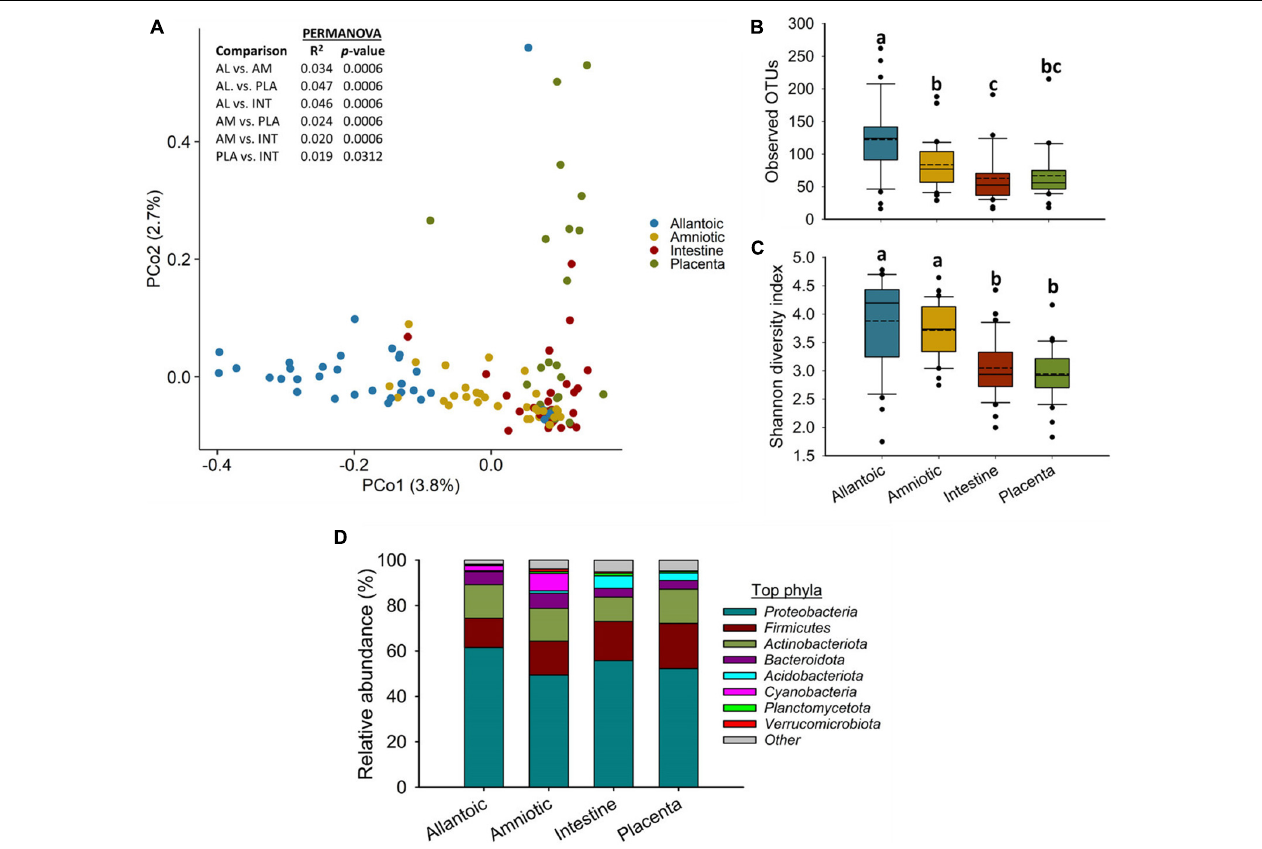
FIGURE 1 | (A) Principal coordinate analysis (PCoA) plot of the Bray-Curtis dissimilarities, (B) the number of operational taxonomic units (OTUs), (C) Shannon diversity index and (D) Percent relative abundance of the eight most relatively abundant phyla present in the allantoic and amniotic fluid and intestinal and placental microbiota of 83-day-old calf fetuses. The different lowercase letters indicate significantly different means ( P < 0.05).